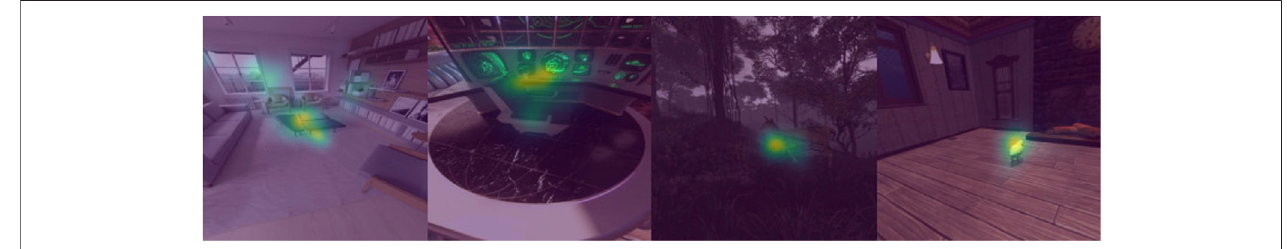
FIGURE 2 | Eye fi xation maps generated through our algorithm overlaid on-top of the actual image. The maps are generated by applying a Gaussian blur over the fi xationsprojectedthroughouralgorithm. Section3.2 explainsthedetailsonouralgorithm.Theimagesarefromthe SaliencyinVR (Sitzmannetal.,2018)andthe DGaze (Hu et al., 2020)